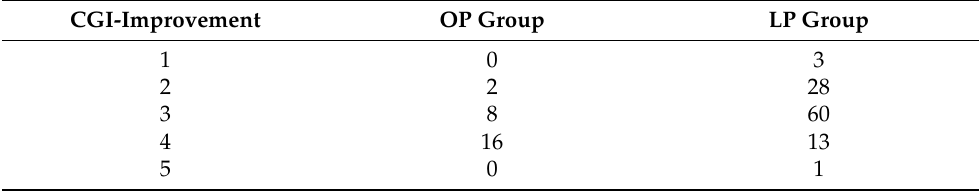
Table 4. CGI-Improvement